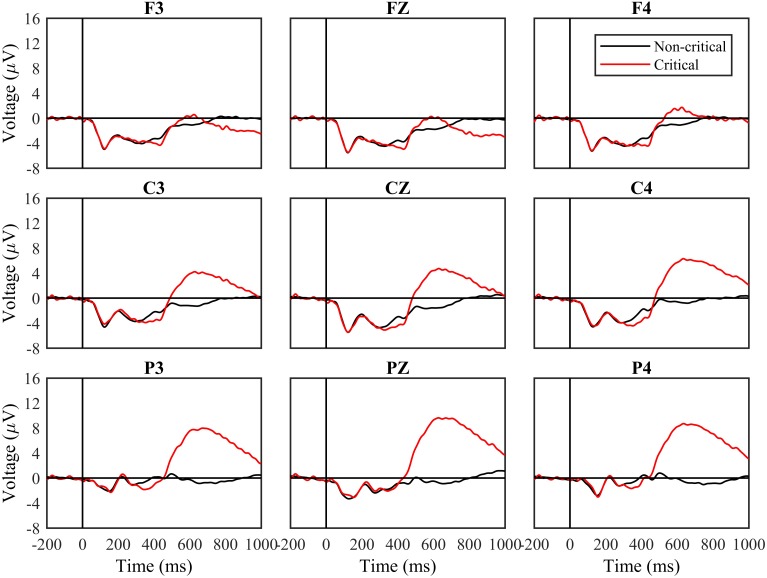
Event-related potential (ERP) waveforms by stimuli type for the entire task. Waveforms following critical and non-critical stimuli. Red line indicates critical stimuli ERP waveforms and the black line indicates non-critical ERP waveforms. The “0” time point represents when the stimulus appeared.